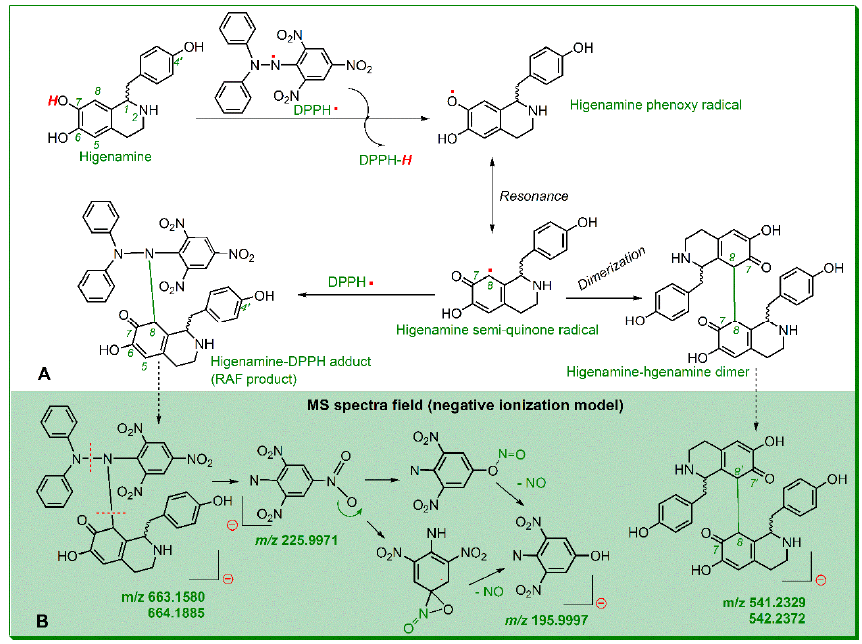
Figure 3. Possible radical-adduct-formation (RAF) reactions between higenamine and 1,1-diphenyl- 2-picryl-hydrazl radical (DPPH • ) ( A ), and MS spectral elucidations ( B